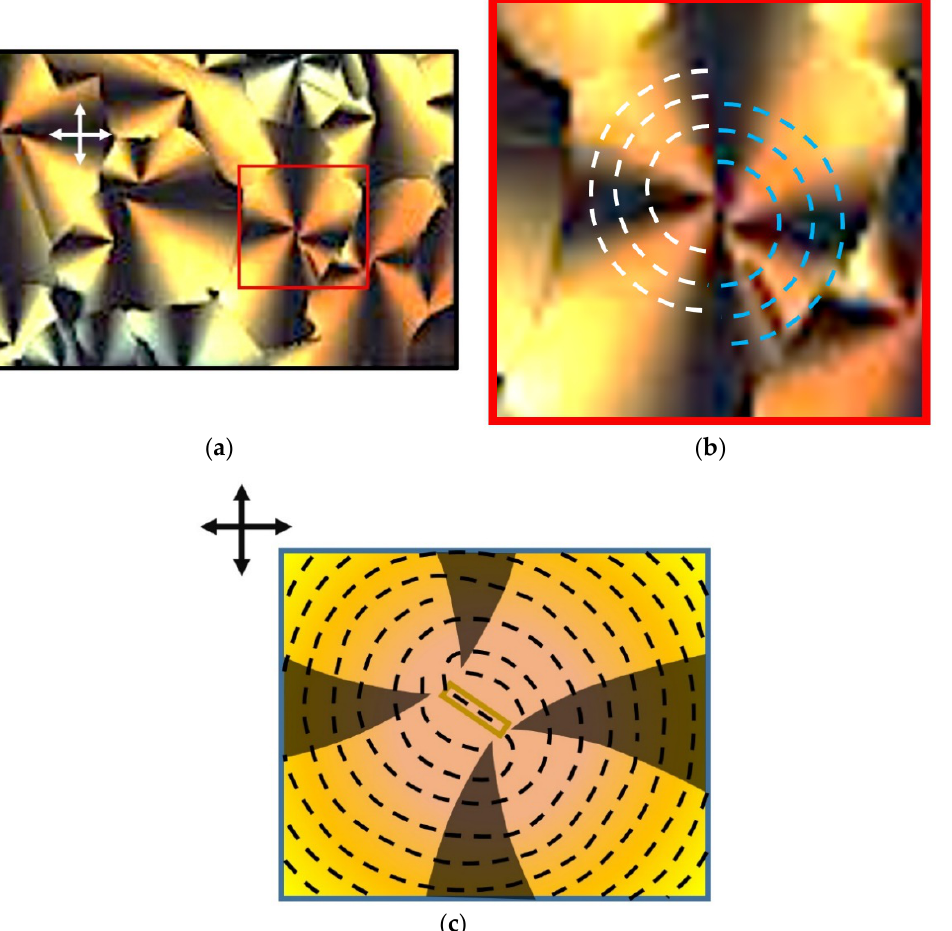
Figure 15. ( a ). The optical texture of the chromonic liquid crystalline phase formed by a concentrated aqueous solution of short-stranded DNA. Taken from [23]. Note the faint, straight line in the middle of the outlined square, which appears to join the two pairs of poles centring the pattern of striations. Furthermore, note the way in which the four dark brushes curve as they approach the poles (a pattern that is repeated in other parts of the micrograph). ( b ) An enlarged view of the square outlined in ( a ), with the pattern of striations superimposed. ( c ) A stylized sketch of the optical texture in the region of the multipole nucleus, stressing the curvature of the dark extinguished areas of the optical texture and showing the proposed pattern of the director field around the complex nucleus.